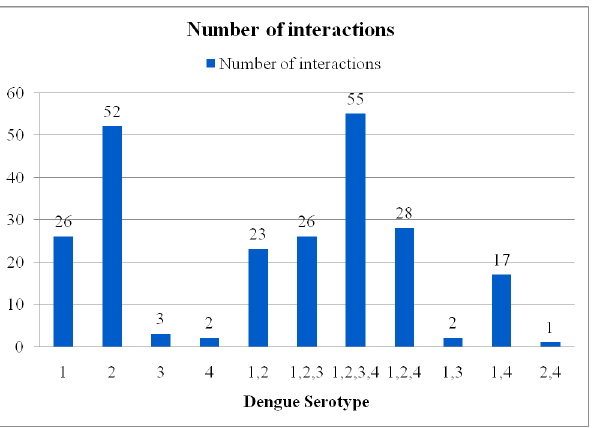
Fig 8. Number of dengue–mosquito interactions with the corresponding proteins, with 1, 2, 3, 4, or a subset of serotypes. Dengueserotypes 1–4 interact with maximum number of mosquito proteins (55).